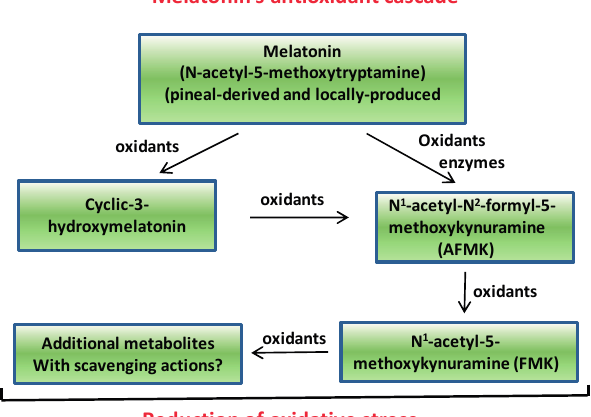
Figure 1. This figure illustrates what has come to be known as the melatonin antioxidant cascade. When it functions in the scavenging of free radicals, melatonin generates the metabolites indicated, all of which are also radical scavengers. This series of reactions greatly increases the ability of melatonin to limit oxidative